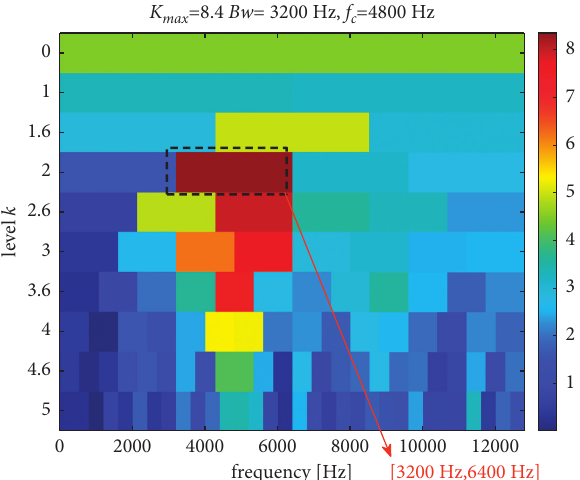
Figure 14: FSK map of the ER-12K bearing with outer ring